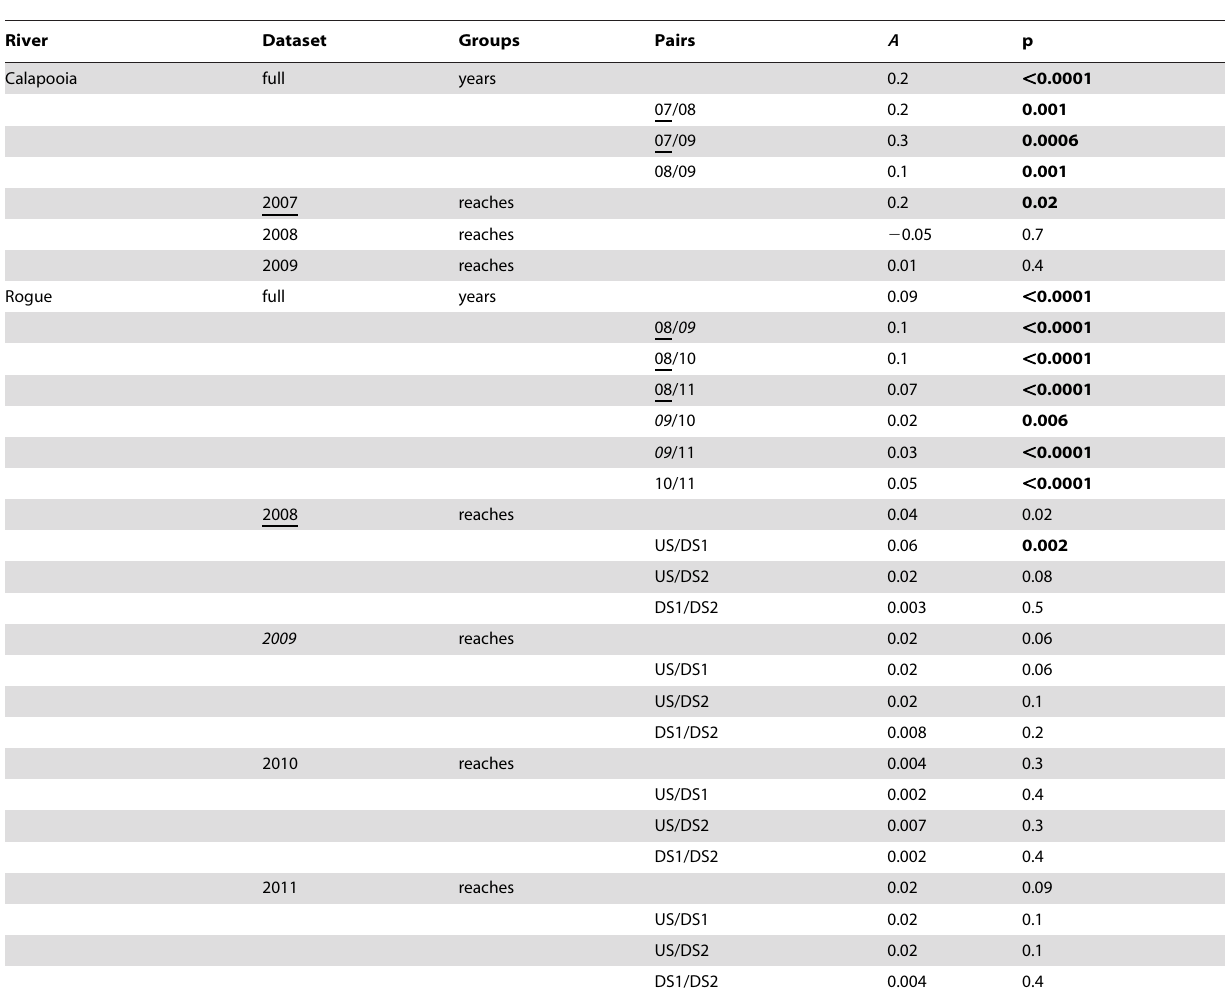
Table 3. Results of MRPP analysis for differences among taxonomically defined assemblages in both rivers.